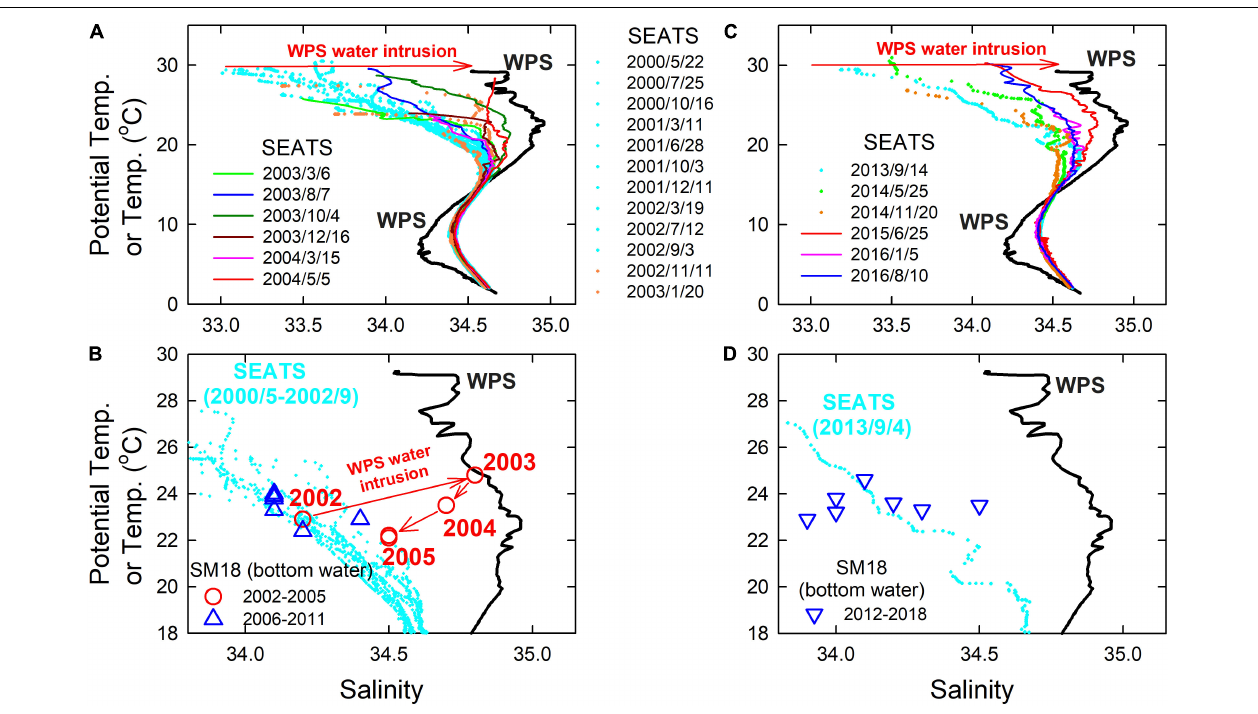
FIGURE 8 | θ -salinity diagram of the water column at SEATS in (A) 2000–2004 and (C) 2013–2016. Temperature—S max of the bottom water at SM18 in (B) 2002–2011 and (D) 2012–2018. The typical plot for WPS water collected at station 21 in the WPS in 1991/6 (black solid line), as well as the θ and salinity values at SEATS between 2000/5/22 and 2002/9/3 [cyan dot in (A) ] and 2013/9/4 [cyan dot in (C) ] are shown in (B,D) , respectively, for reference. The numbers in (B) show the years of the data at